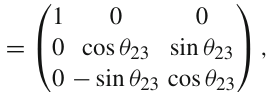
and F := ( F 1 , F 2 , F 3 ) T is thought of as a column 3-vector in family space and V F are unitary 3 by 3 matrices. After Table1 FieldcontentoftheTFHMandrepresentationsunderthegauge such mixing, the CKM quark-mixing matrix and the PMNS group. i ∈ { 1 , 2 } is a family index for the first two families. The left- lepton-mixing matrices are := ( u (cid:2) , d (cid:2) ) T and L (cid:2) := handeddoublesfurtherdecomposeas Q (cid:2) L α L α L α L α , ν (cid:2) ) T , respectively, where α ∈ { 1 , 2 , 3 } . Here, allfieldsare listed (ν (cid:2) L α L α in the (primed) gauge eigenbasis and the hypercharge gauge boson B (cid:2) μ and Y 3 gauge boson ( X μ (cid:2) ) fields are defined in a basis in which there is respectively. The original example case of the TFHM’s no kinetic mixing between them assumptions, which we shall adhere to here, correspond to: Field The example case allows b L − s L mixing,